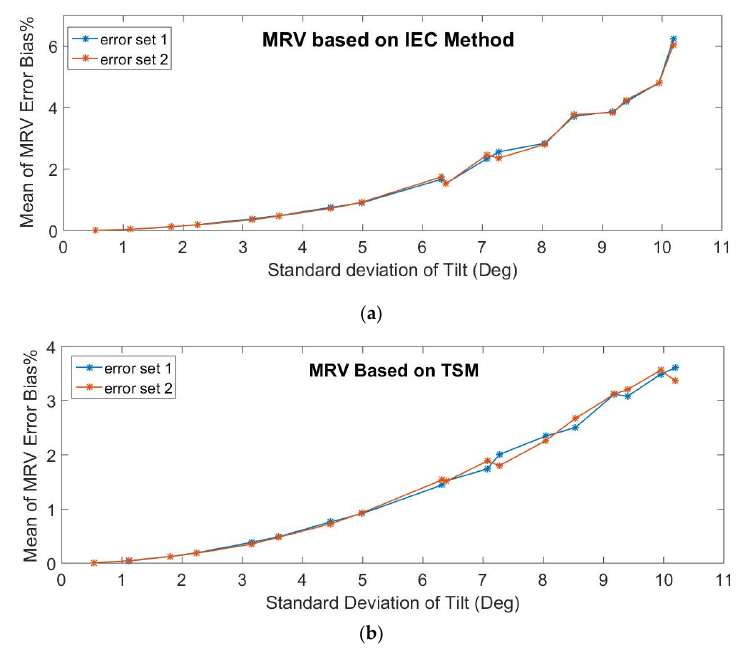
Figure A1. Means of MRV error variation with tilt ( a ) based on the IEC method; ( b ) based on the TSM.